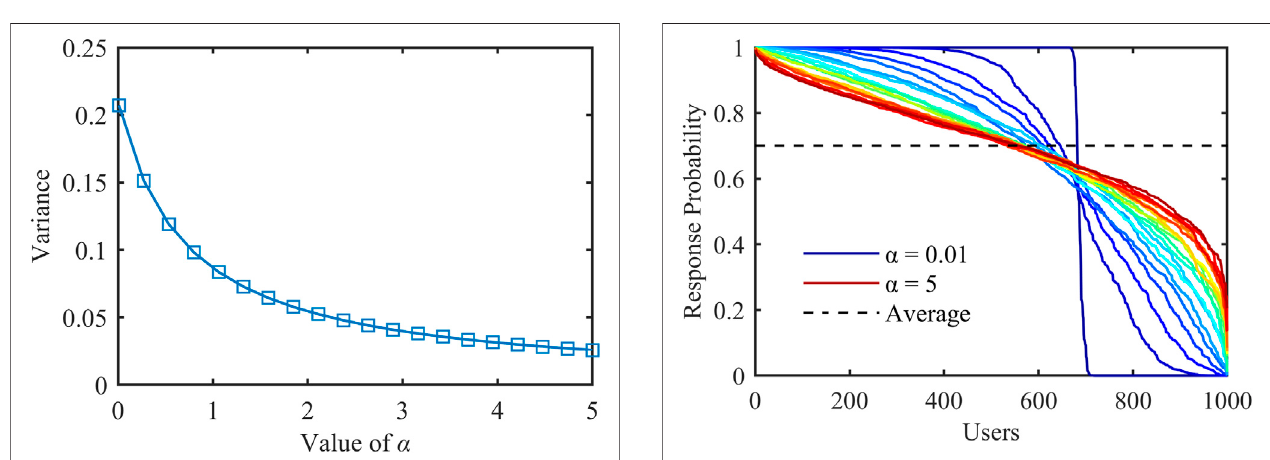
FIGURE 3 | Curve graph.